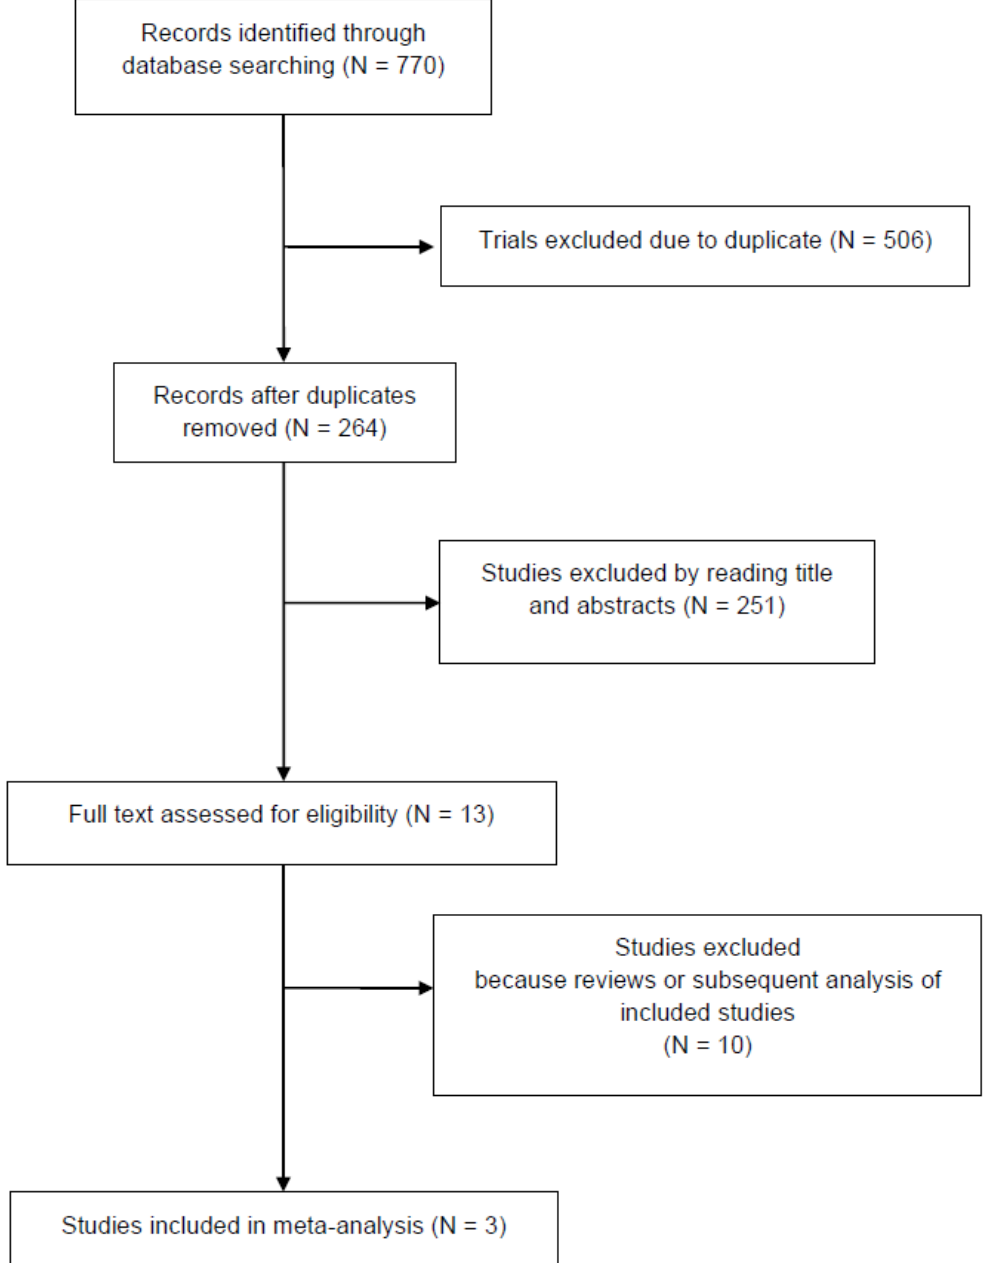
Figure 1. The trial selection flow chart.